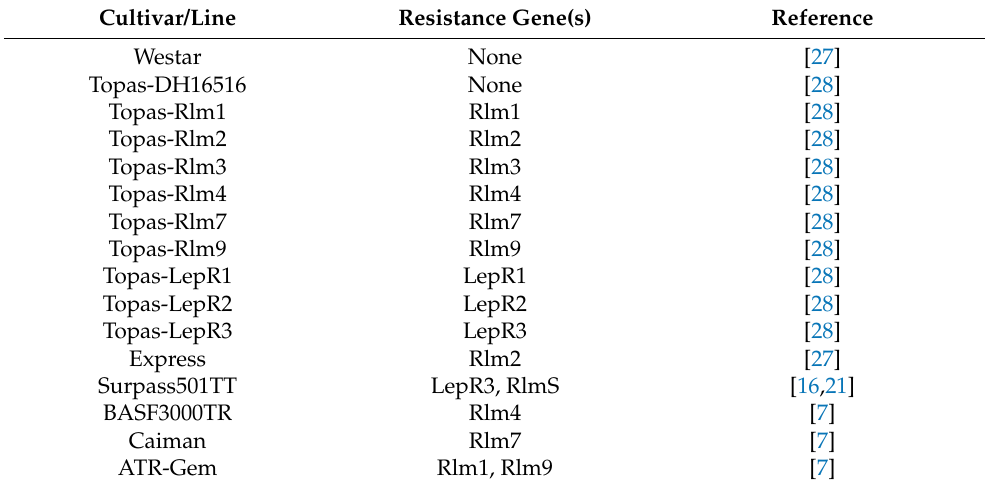
Table 1. Control B. napus lines/cultivars used for testing molecular markers and phenotyping. Cultivar/Line Resistance